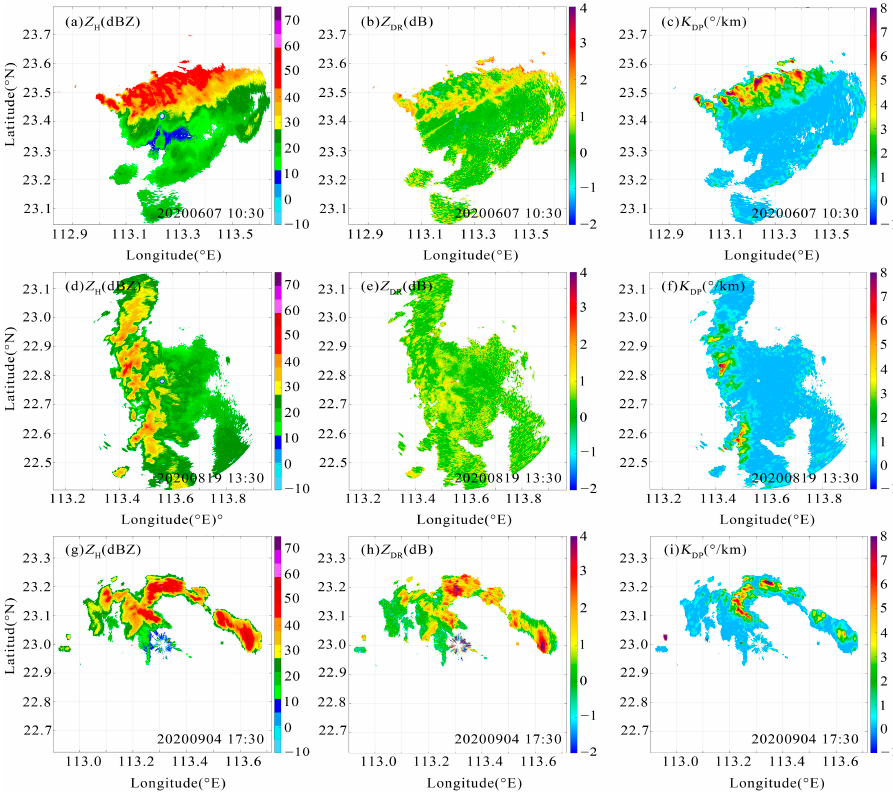
Figure 8. Z H , Z DR , and K DP observed by the X-band PAR radar at the 2.7-deg-elevation in the ( a – c ) pre-summer rainband at 10:30 on June 7, the ( d – f ) typhoon rainband at 13:30 on August 19, and the ( g – i ) severe convective rainband at 17:30 on September 4. ( g – i ) severe convective rainband at 17:30 on September